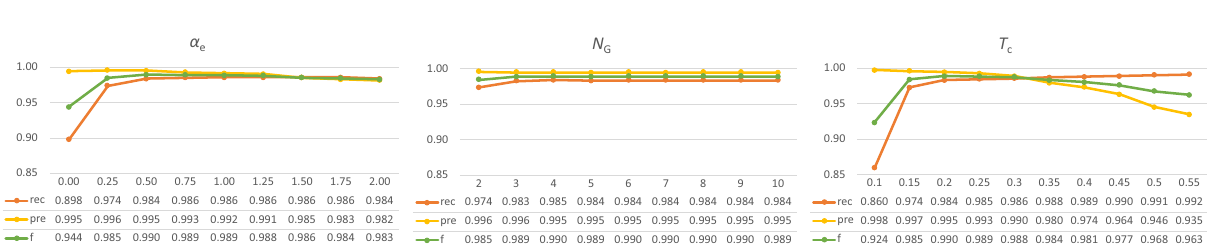
Table 2. Set of parameters used in the reported results.